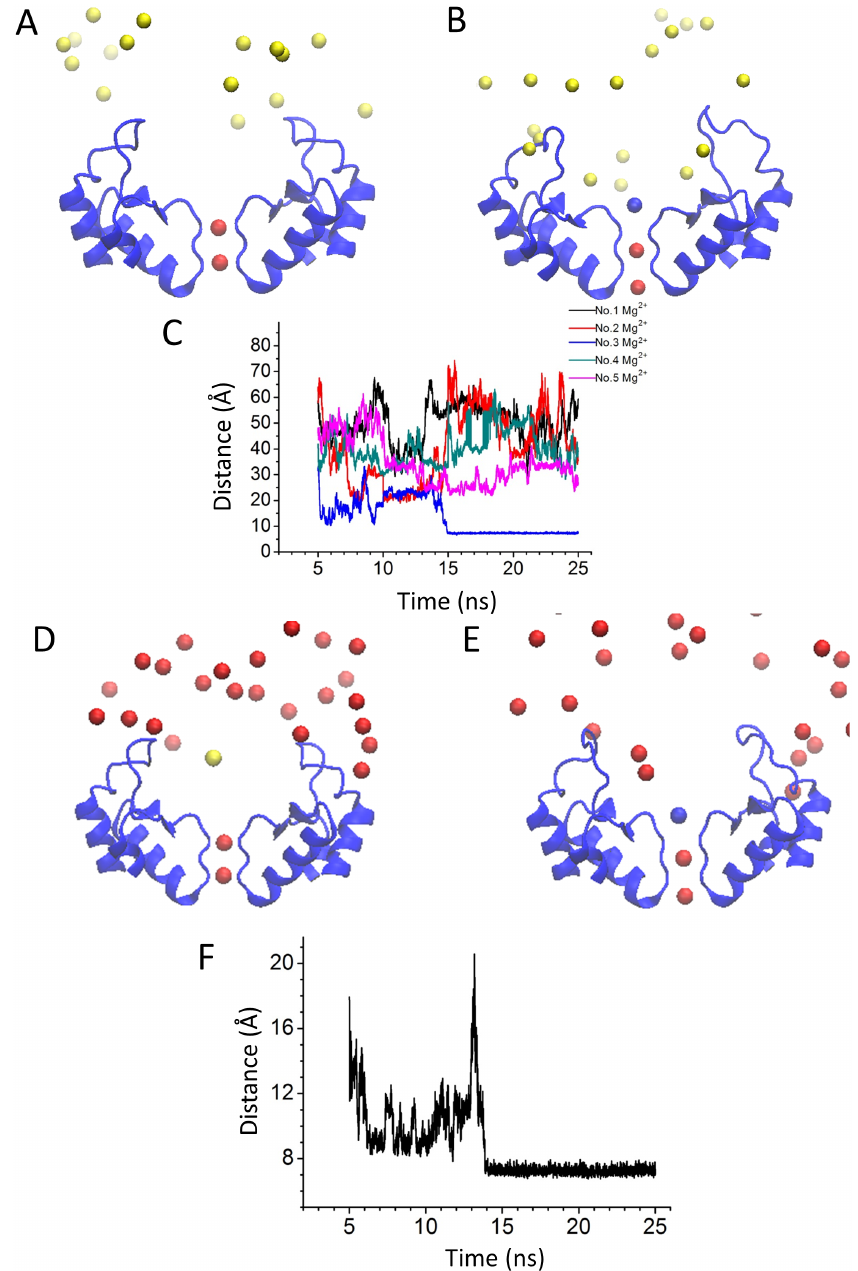
Figure 3. Mg 2 + ion binds at the S0 site of Kir2.2 both in high and physiological conditions. Distributions of extracellular K + and Mg 2 + ions of the initial (A and D) and final (B and E) snapshots. Mg 2 + and K + ions are represented by yellow and red spheres, respectively. In panel B and E, the blue spheres represent the binding Mg 2 + ions. (C and F) Evolution of the distance (between the center of the selective filter and each Mg 2 + ) against time (5–25 ns). The total simulation time was 25 ns. In the first 5 ns, the ions are fixed for equilibration of the lipids. The No. 3 Mg 2 + is corresponding to the bound Mg 2 + . doi:10.1371/journal.pone.0111372.g003 smooth switching function starting at 10 A˚ and a nonbonded characteristic: (a) Three-dimensional periodic boundary conditions ‘‘pairlist’’ distance of 13.5 A˚ ; (d) A time-step of 2 fs was used to were applied and long-range electrostatic forces were calculated integrate the equations of motion and a reversible multiple time- using the particle mesh Ewald (PME) [43,44] approach step algorithm of 4 fs was used for the electrostatic forces and 2 fs (108 6 108 6 200 grid points) with a grid spacing of , 1 A ˚ in each for short-range, nonbonded forces. Overall, , 175 ns of simulation dimension; (b) The Langevin dynamics scheme was used to keep time was generated and , 155,000 CPU hours were used in the temperature constant at 310 K. The Nose-Hoover-Langevin calculating the results in this study. piston was used to maintain the constant pressure at 1 atm; (c) The cutoff radius for Lennard Jones interactions was 12 A ˚ , with a